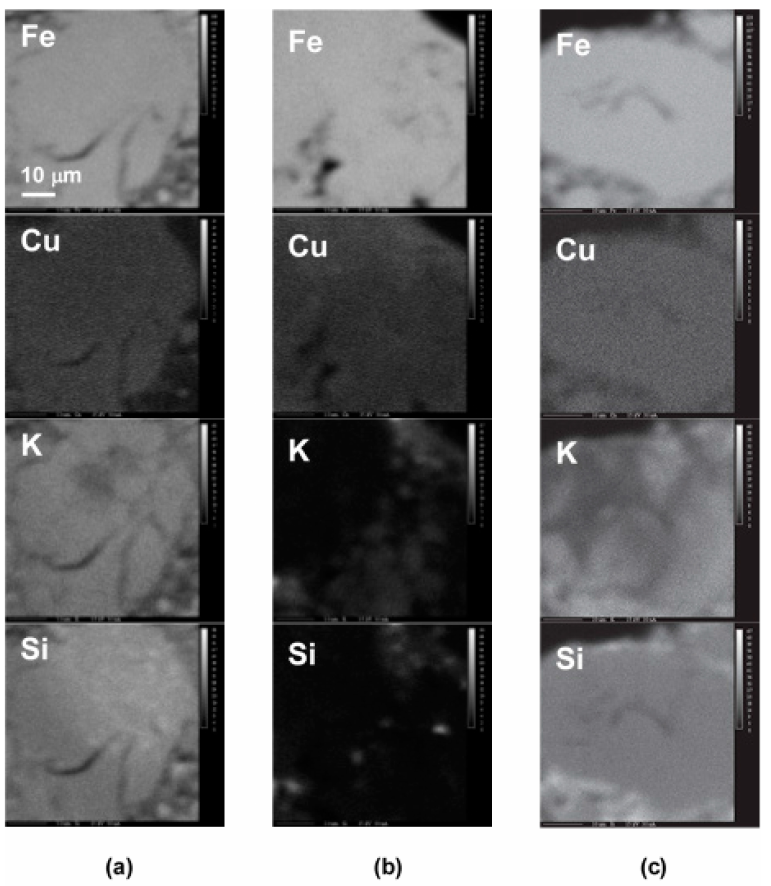
Figure 1. Electron microprobe images showing distributions of Fe, Cu, K, and Si of an agglomerate of ( a ) 1UH, ( b ) 2UH, and ( c )